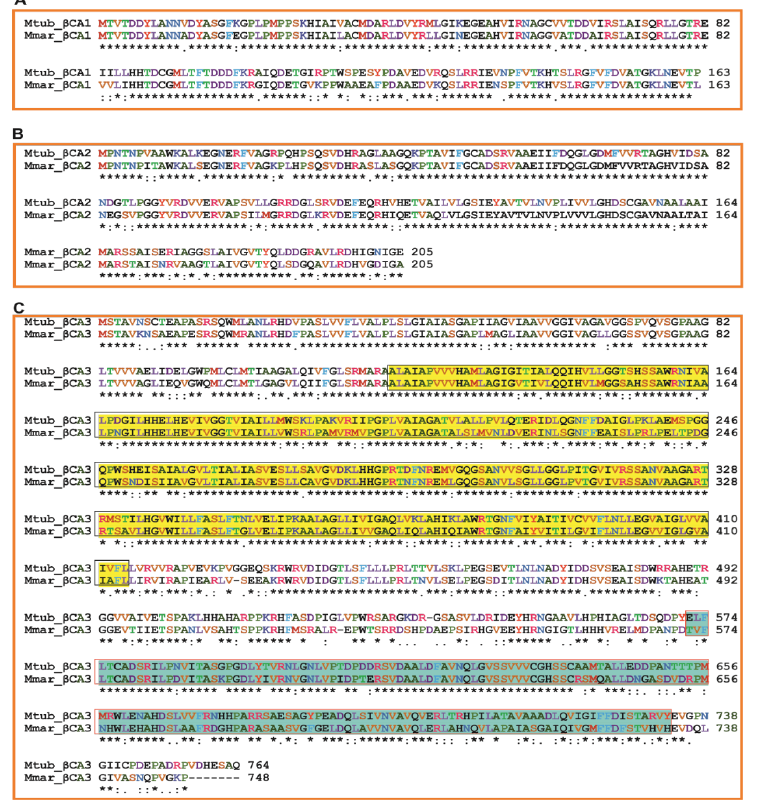
Figure 4. Alignment of the Mtb and Mmar β -CA protein sequences. Conserved amino acid residues between the three Mtb CAs (UniProt IDs: Rv1284/CA1, Rv3588c/CA2, and Rv3273/CA3) and the corresponding Mmar β -CA sequences are indicated by asterisks. ( A ) Shows the alignment of β -CA1 sequences of Mtb and Mmar ; ( B ) Shows the alignment of β -CA2 sequences of Mtb and Mmar ; and ( C ) shows the alignment of β -CA3 sequences of Mtb and Mmar. The boxed yellow and blue highlighted parts show the N-terminal sulfate transporter and C-terminal CA domains,